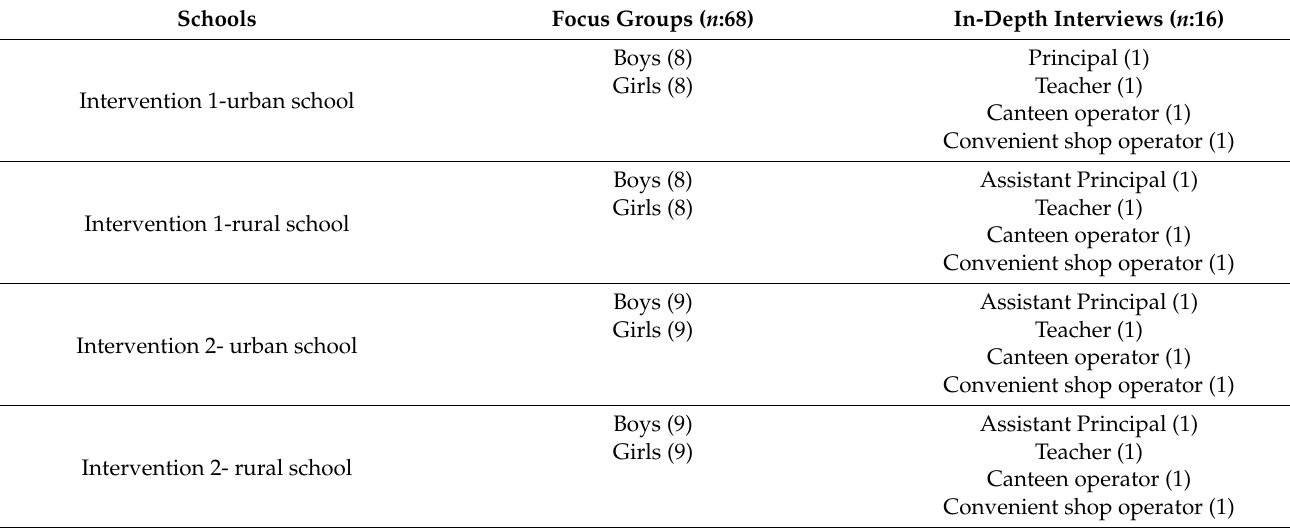
Table 1. Participation in Focus Group Discussions and